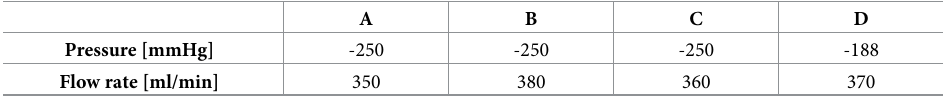
Table 4. Gauge pressure values applied at catheter outlets and respective flow rates achieved